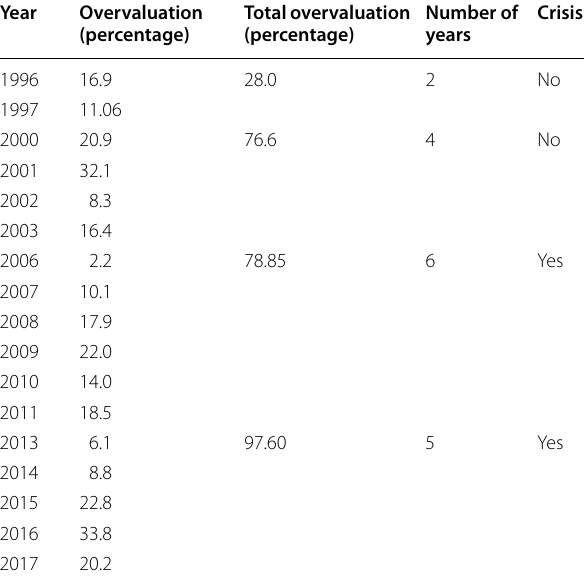
Table 5 Ratio of overvaluation to exchange